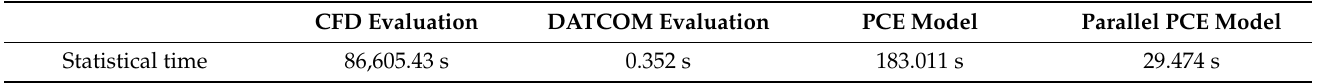
Table 4. Statistical time under different aerodynamic performance evaluation